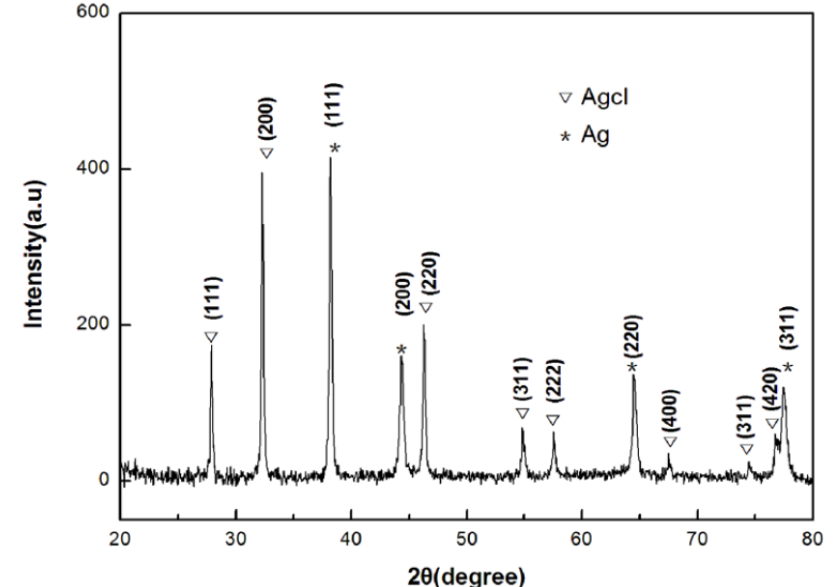
Figure 2. X-ray diffraction (XRD) pattern of Ag/AgCl